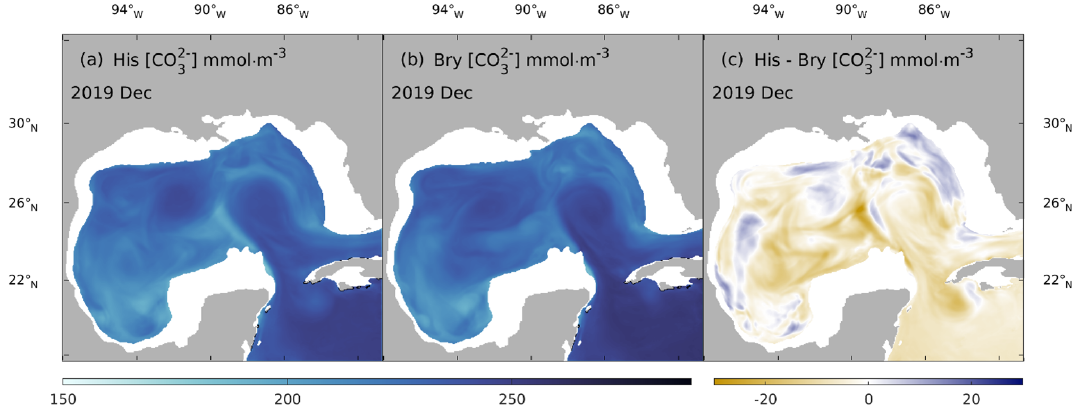
Figure 14. Comparison of monthly averaged carbonate ion concentration ([CO 2 − cember mean [CO 2 − ] of the His experiment, (b) December mean [CO 2 − 3